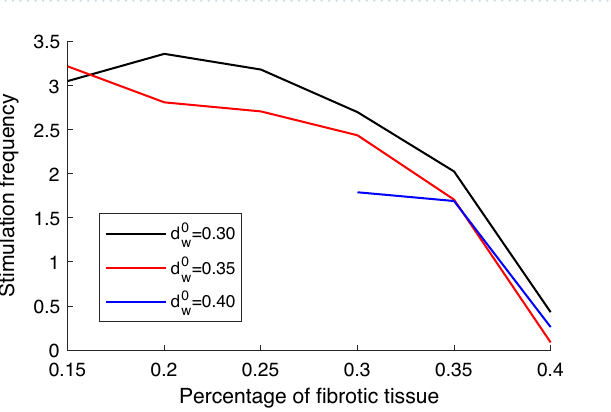
0 w . Frequency stimulation